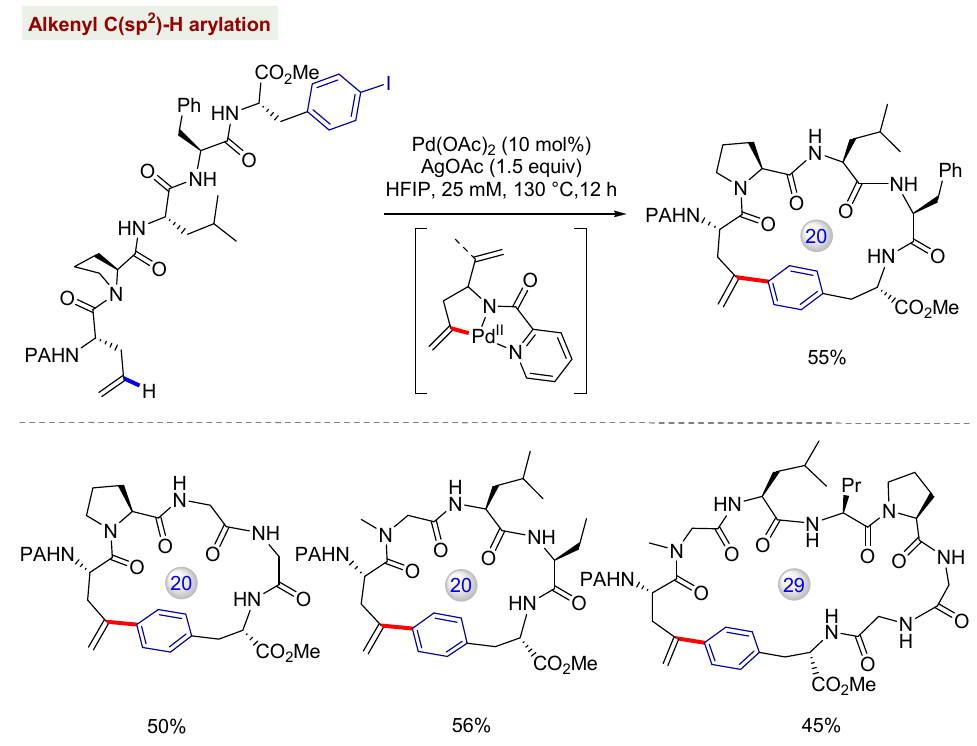
Figure 13. Synthesis of cyclophane ‐ braced peptide macrocycles through palladium ‐ catalyzed intramolecular vinyl and aryl C(sp 2 ) − H arylation [72].